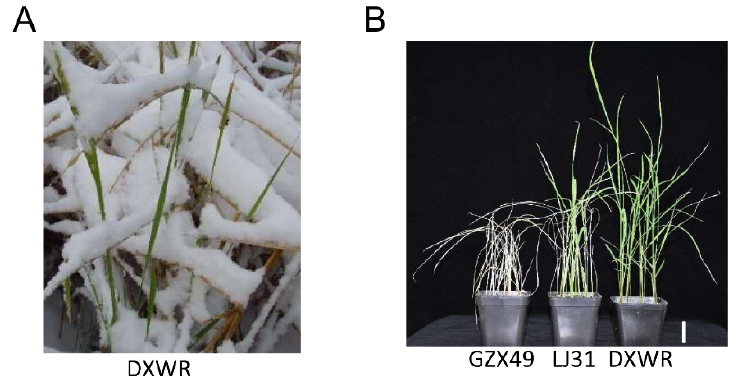
Figure 6. Cold tolerance phenotype of DXWR. ( A ) The phenotype of DXWR encountering heavy snow weather in its habitat. ( B ) Phenotypes of DXWR, Longjing 31, and GZX49 after 4 days of treatment at 0 °C at the seedling stage. LJ31 stands for LongJing31. The scale bar of ( B ) means 5 cm.